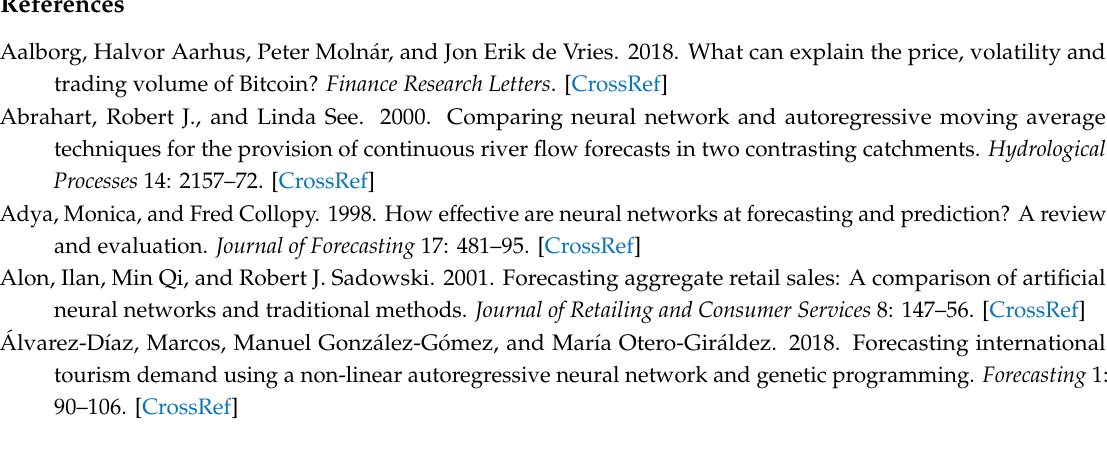
Figure A2. Examined NNAR model performance. ( a , b ) The second training and test-sample forecast performance, respectively.